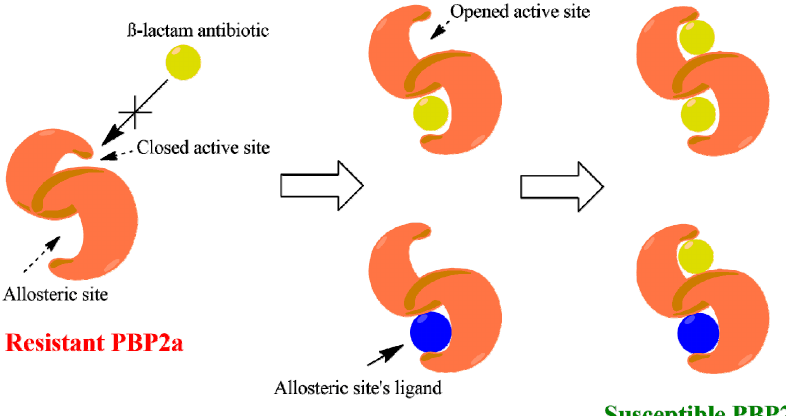
Figure 7. An illustration of the allosteric-mediated reversing of PBP2a resistance toward β -lactam antibiotics.